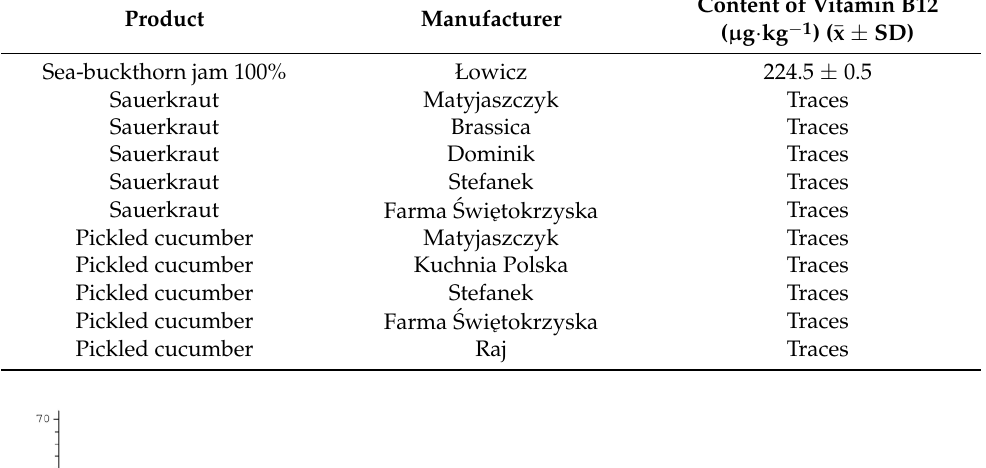
Table 1. Content of cyanocobalamin in solid samples of fermented vegetable products.